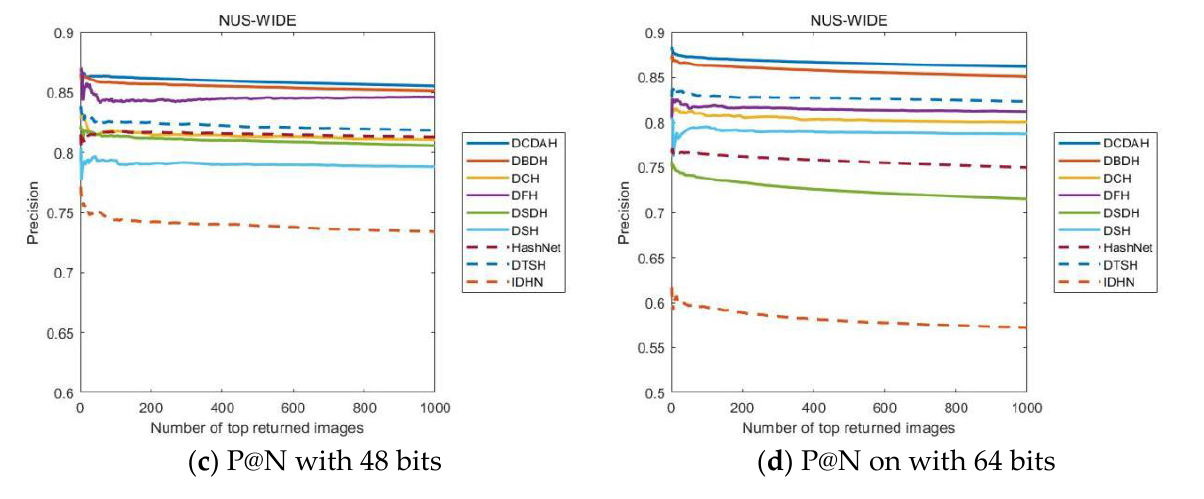
Figure 9. The P@N curves of all algorithms on NUS-WIDE when the hash code takes 4 different lengths.